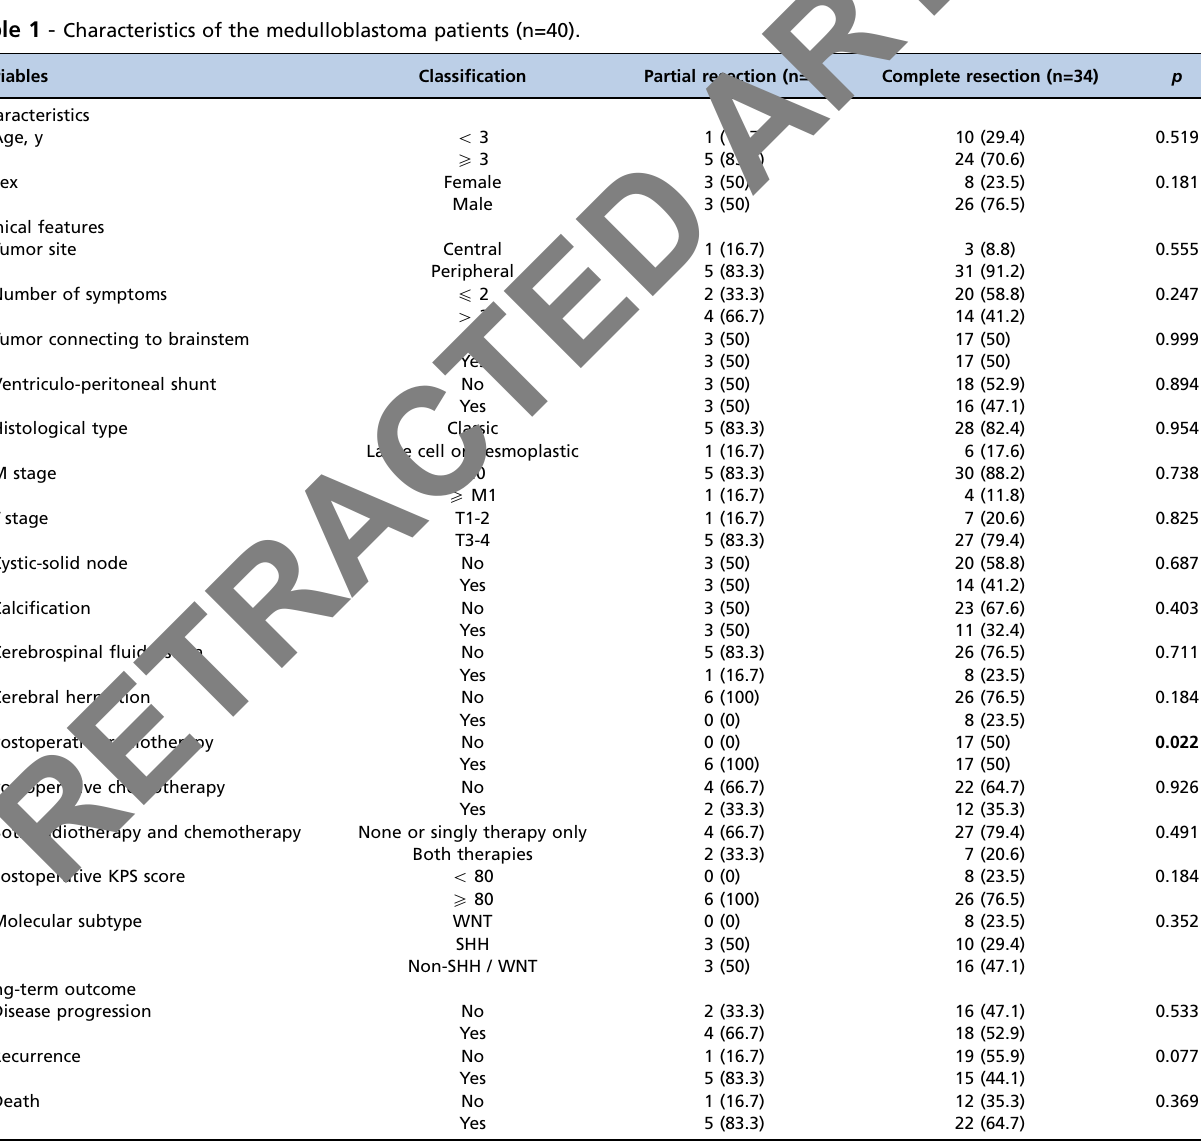
Table 1 - Characteristics of the medulloblastoma patients